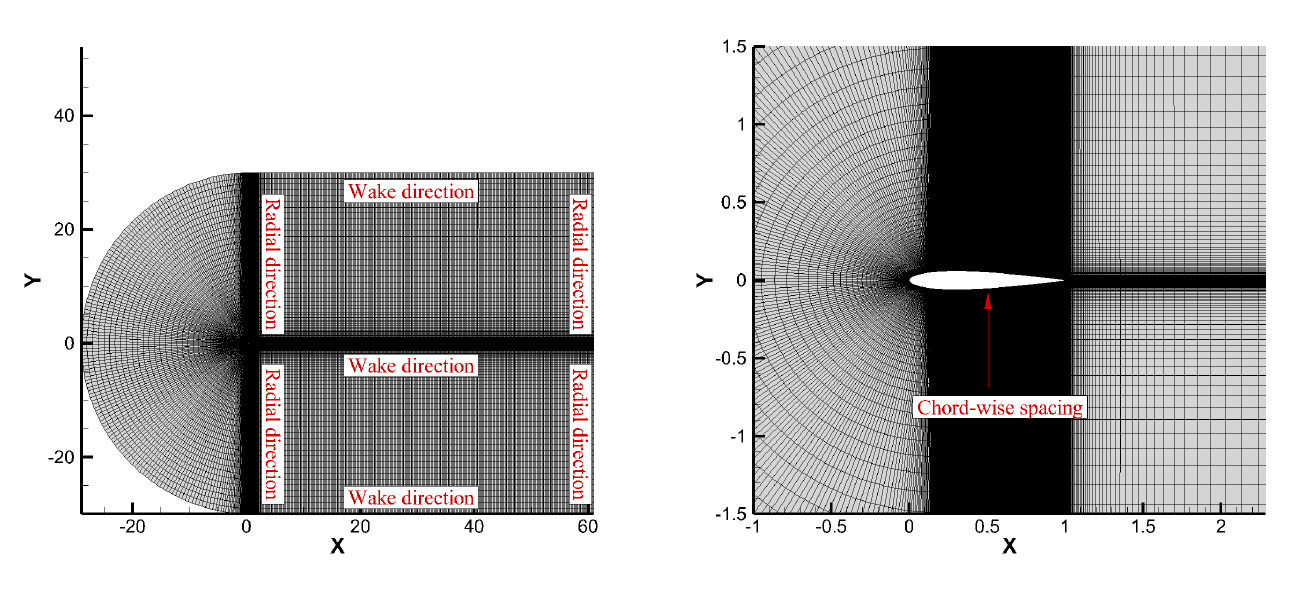
Figure 13. Node distributions for